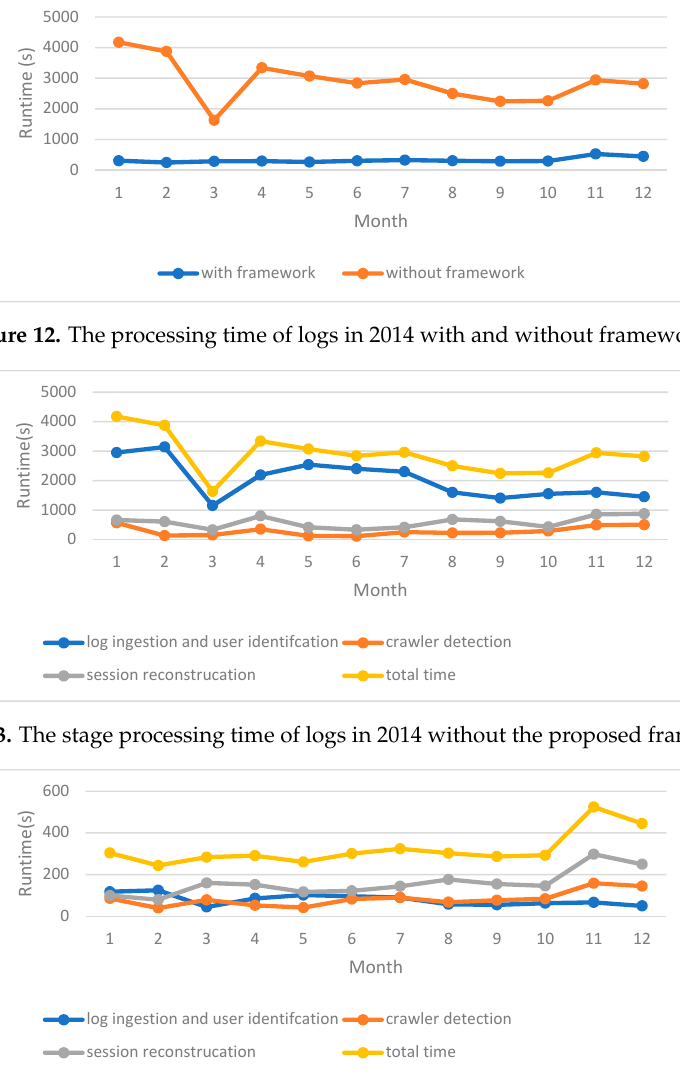
Figure 14. The stage processing time of logs in 2014 with the proposed framework.